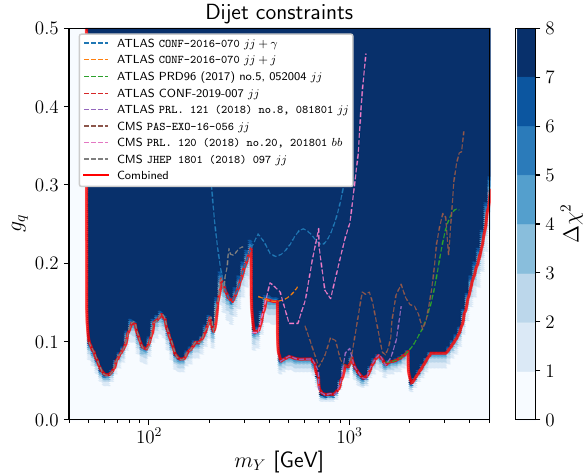
0 . 10 2 10 3 m Y [GeV] Fig. 3 Comparison of our implementation of the LHC dijet invariant- mass constraint, indicated by the colour coding, with a compilation of the limits published by the ATLAS and CMS Collaborations [87–93], for a Z (cid:15) boson, in the plane of its mass and coupling to the